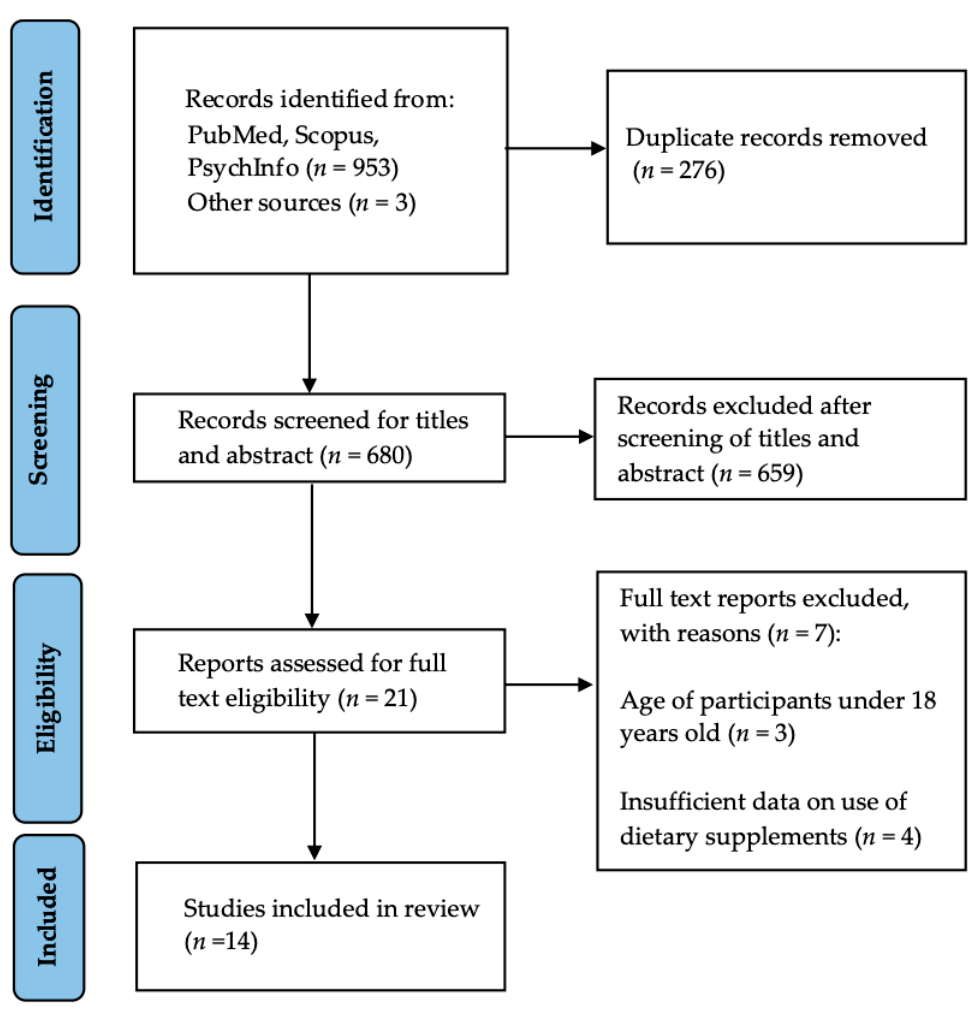
Figure 1. PRISMA 2020 flow diagram displaying the scoping review process.